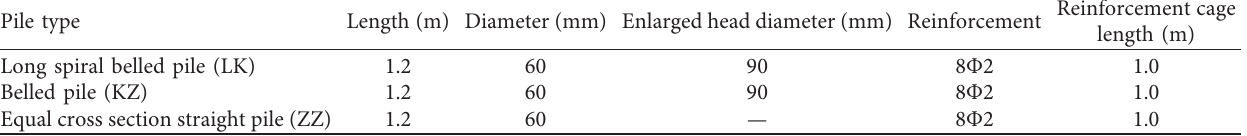
Table 1: Parameter table of model pile.